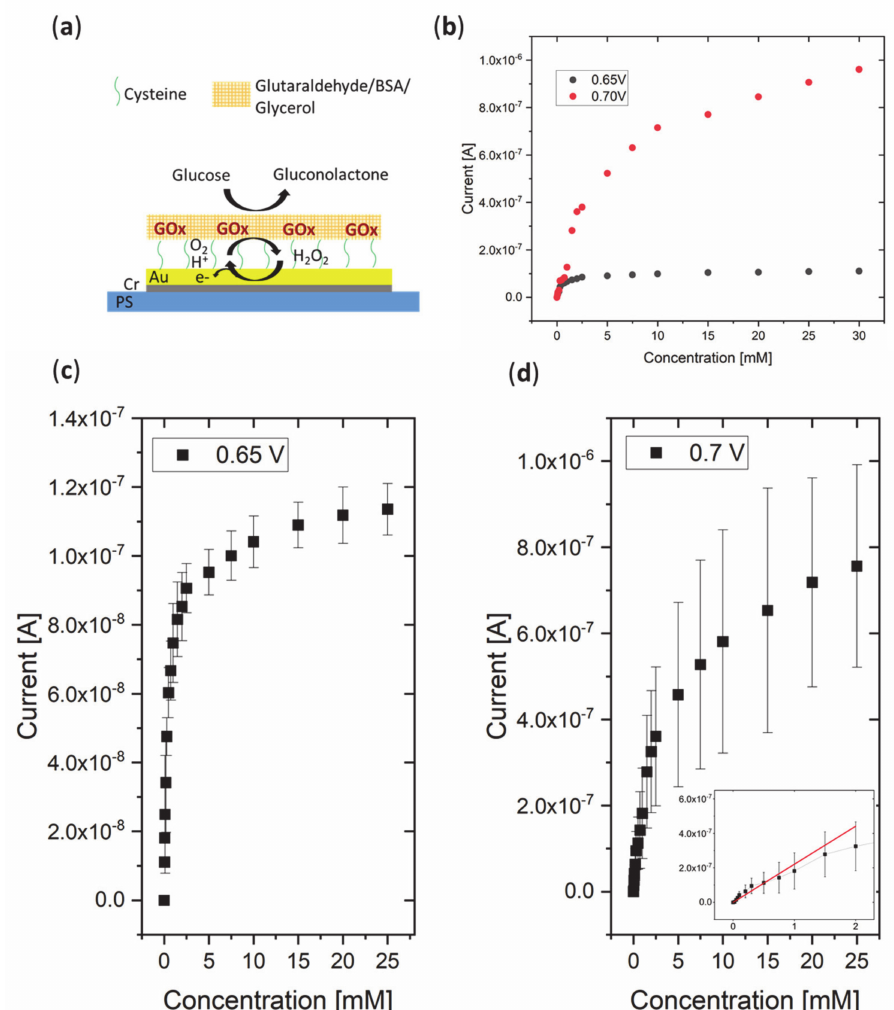
Figure 3. ( a ) Scheme of sensing mechanism of the glucose oxidase (GOx)-functionalized Au elec- trode. ( b ) Exemplary calibration plots of the GOx-functionalized Au electrode in different glucose concentrations for ( c ) 0.65 V ( n = 3) and ( d ) 0.7 V ( n = 3). A linear increasing current response for increasing glucose concentrations was found between 0.025 mM and 2 mM at 0.7 V (inset), whereas the operational range was up to 25 mM at both potentials before saturation occurred. n = number of analyzed